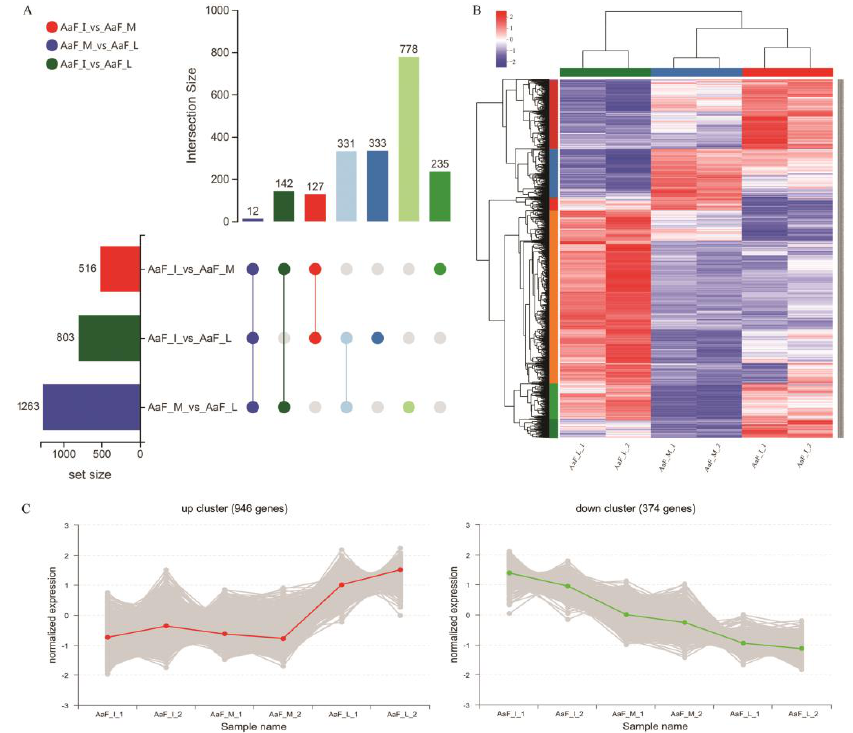
Figure 2. Analysis of transcriptome data from A. arguta fruit at three developmental stages. AaF_I, AaF_M, and AaF_L represent the samples at initial stage, middle stage, and last stage, respectively. ( A ) UpSetR plot of significantly differentially expressed genes. ( B ) Unigene cluster analysis between the three developmental stages. ( C ) Cluster trend analysis of DEGs between the three developmental